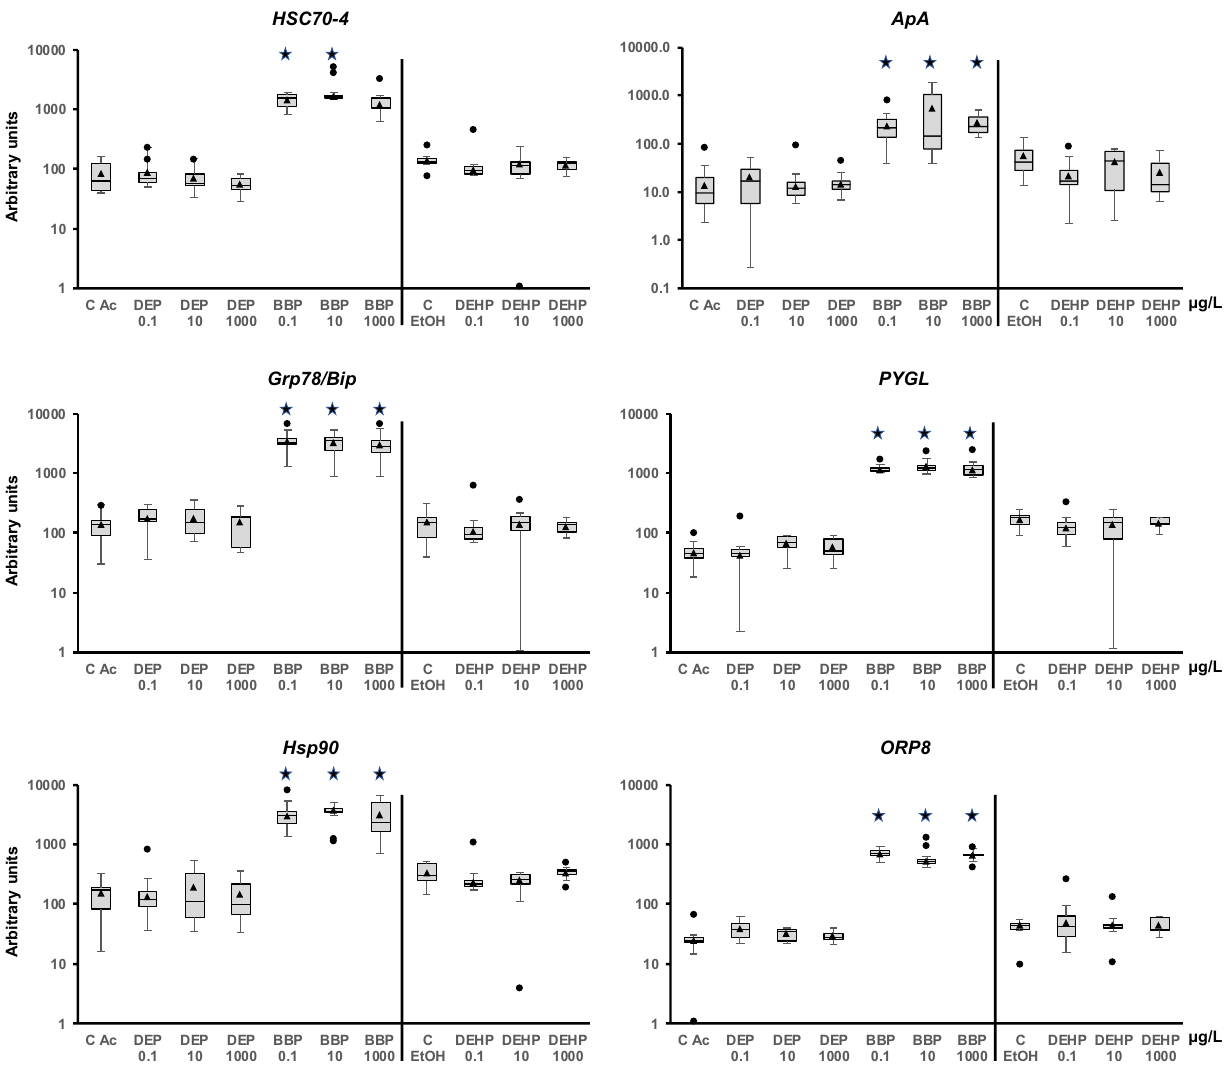
Figure 6. Modulation of genes related to stress ( Hsc70-4 , Grp78 / BiP , and Hsp90 ), immune system ( ApA ), energy metabolism ( PYGL ), and lipid transportation ( ORP8 ) in adult Physella acuta after in vivo exposure to to diethyl phthalate (DEP), benzyl butyl phthalate (BBP), and bis-(2-ethylhexyl) phthalate (DEHP) for 1 week at 19 °C. The mRNA levels were normalized using rpL10 , Act , PFKFB2 , and GAPDH as reference genes. Treatments were compared to respective solvent-exposed (EtOH, acetone) controls. Whisker boxes are shown (n = 9 individuals per box). The median is indicated by the horizontal line within the box, and the 25th and 75th percentiles are indicated by the boundaries of the box. The highest and lowest results are represented by the whiskers. The small triangle inside the box denotes the mean and the outliers are shown (circles). Significant differences to the respective controls (asterisk) are indicated ( p <